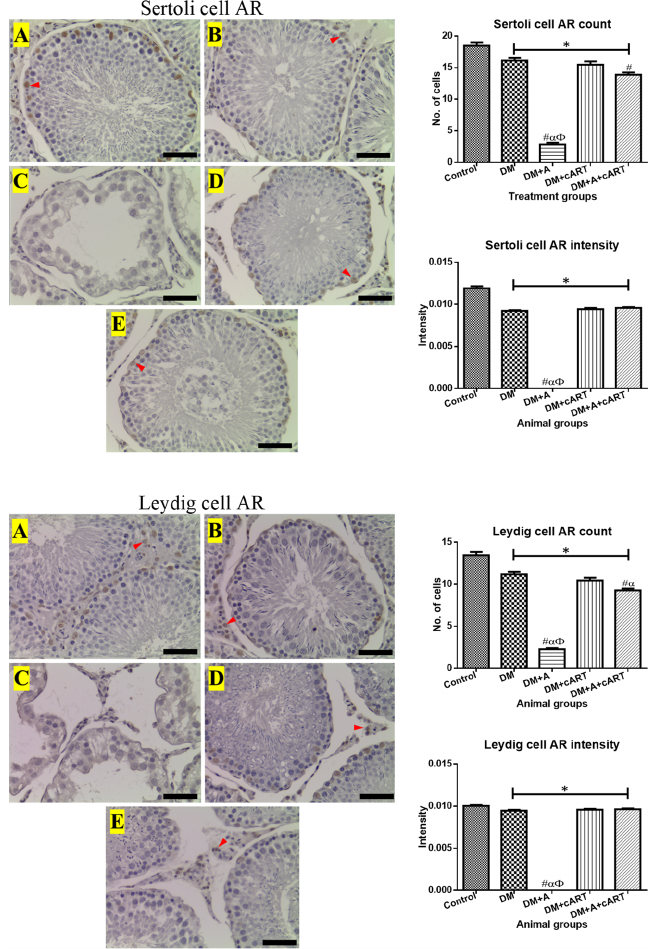
Figure 6. Representative photomicrographs showing Sertoli and Leydig cell androgen receptor (AR) immunoreactivity (arrowheads) and respective graphs of the mean ± SEM number of immunoreac- tive cells and intensity. *, #, α , and φ represent significant differences ( p < 0.05) as analyzed by the Bonferroni’s multiple comparison test: ‘*’ significantly decreased compared to the control group, ‘#’ significantly decreased compared to DM, ‘ α ’ significantly decreased compared to DM+cART, and ‘ φ ’ significantly decreased compared to DM+A+cART. Magnification, × 400; scale bar, 50 µ m. Key: Image: ( A ); control group, ( B ); DM group, ( C ); DM+A group, ( D ); DM+cART group, and ( E ); DM+A+cART group. DM, diabetes; DM+A, diabetes and alcohol; DM+cART, diabetes and combination antiretrovi- ral therapy; DM+A+cART, diabetes and alcohol and combination antiretroviral